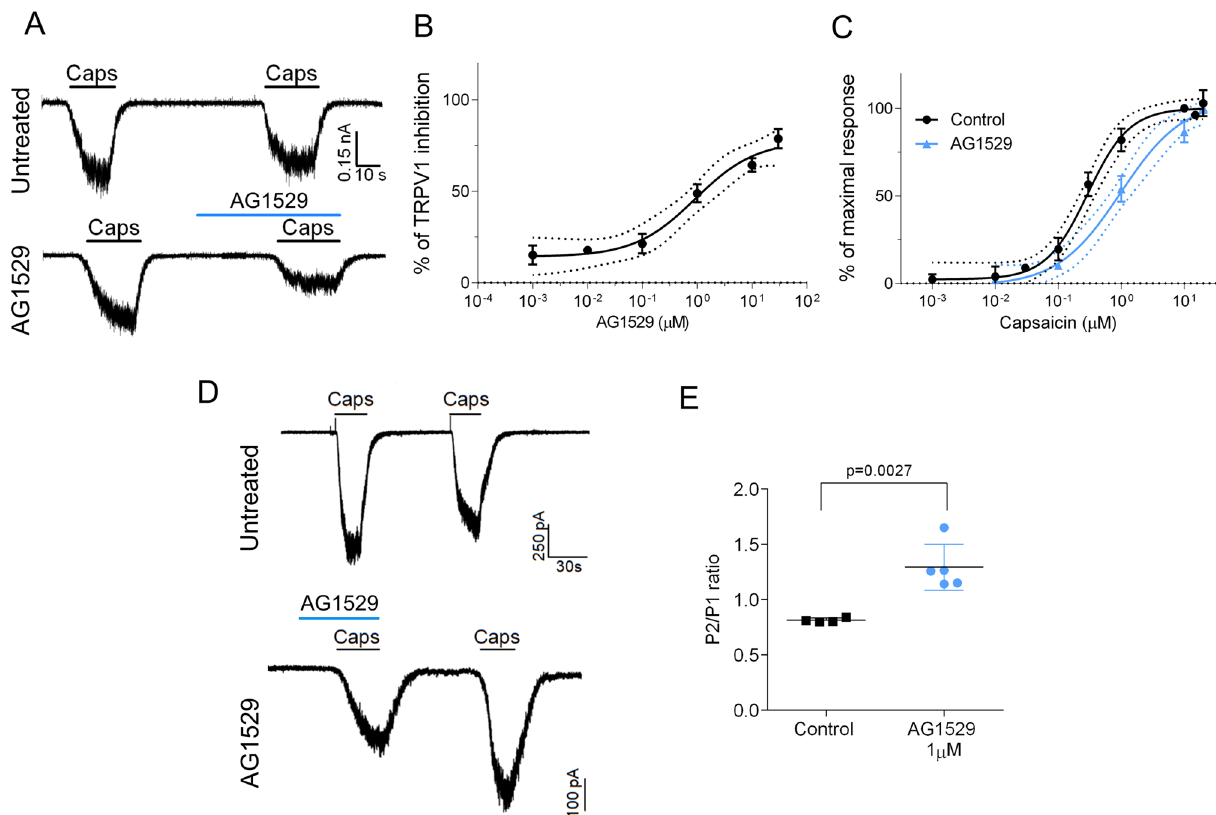
Figure 1. AG1529 reversibly blocks capsaicin activation of hTRPV1. Electrophysiological evaluation of AG1529 on heterologously expressed hTRPV1 channel. ( A ) Representative capsaicin-evoked hTRPV1 current recorded at a holding potential of − 60 mV for: (i) control condition (Untreated cells), where cells were exposed to two capsaicin pulses (0.5 μM), interspersed by a washing period; and, (ii) Treated condition (AG1529 cells), where cells were exposed to a capsaicin pulse (0.5 μM), and after a washing period, cells were exposed to 1 µM AG1529 for 30 s before the second 0.5 μM capsaicin pulse. The percentage of TRPV1 inhibition was calculated as: (% inhibition) = [1 − {(I cap1 − I cap2 ) AG1529 /(I cap1 − I cap2 ) Control }] × 100; (I cap1 − I cap2 ) Control accounts for the extend of TRPV1-induced desensitization by capsaicin (control). ( B ) Dose–response curve of AG1529 were fitted to a Michaelis–Menten Isotherm. The best fit provided an IC 50 value of 0.92 (95% CI 0.28–3.01) µM and Hill coefficient of n H 1.31 (95% CI 0.81–1.82) (n = 32). ( C ) Capsaicin dose response in the absence (black) and presence of AG1549 (blue). Data were fitted to a Michaelis–Menten Isotherm. The best fitted values for capsaicin EC 50 value was 0.29 (95% CI 0.20–0.35) µM (n = 29) in the absence of 1 µM AG1529 and 0.98 (95% CI 0.6–1.13) µM in its presence (blue curve, n = 21). Hill coefficient in the absence of AG1529 was 1.3 (0.9–1.6) and in its presence was 1.00 (95% CI 0.7–1.2). ( D ) Representative repetitive capsaicin-elicited hTRPV1 currents recordings at − 60 mV holding potential in the absence (Untreated cells) and presence of 1 µM AG1529 before the first vanilloid pulse (AG1529). ( E ) P2/P1 ratio denoting TRPV1 current evoked by each 0.5 μM capsaicin pulse, normalized to first vanilloid pulse, in the absence (control, n = 4) and the presence of 1 µM AG1529 (n =